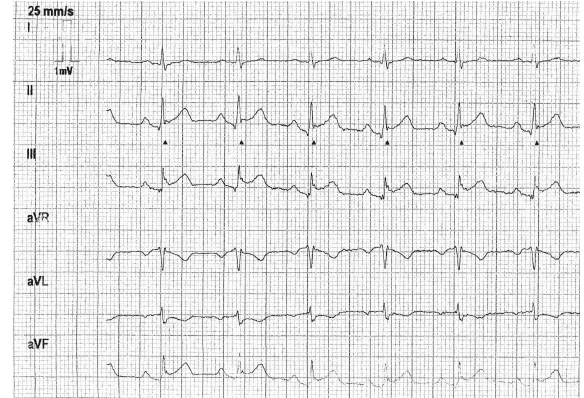
Figure 1: ECG on admission showing ST elevation in leads II, III, and aVF as well as slight reciprocal changes in leads I and